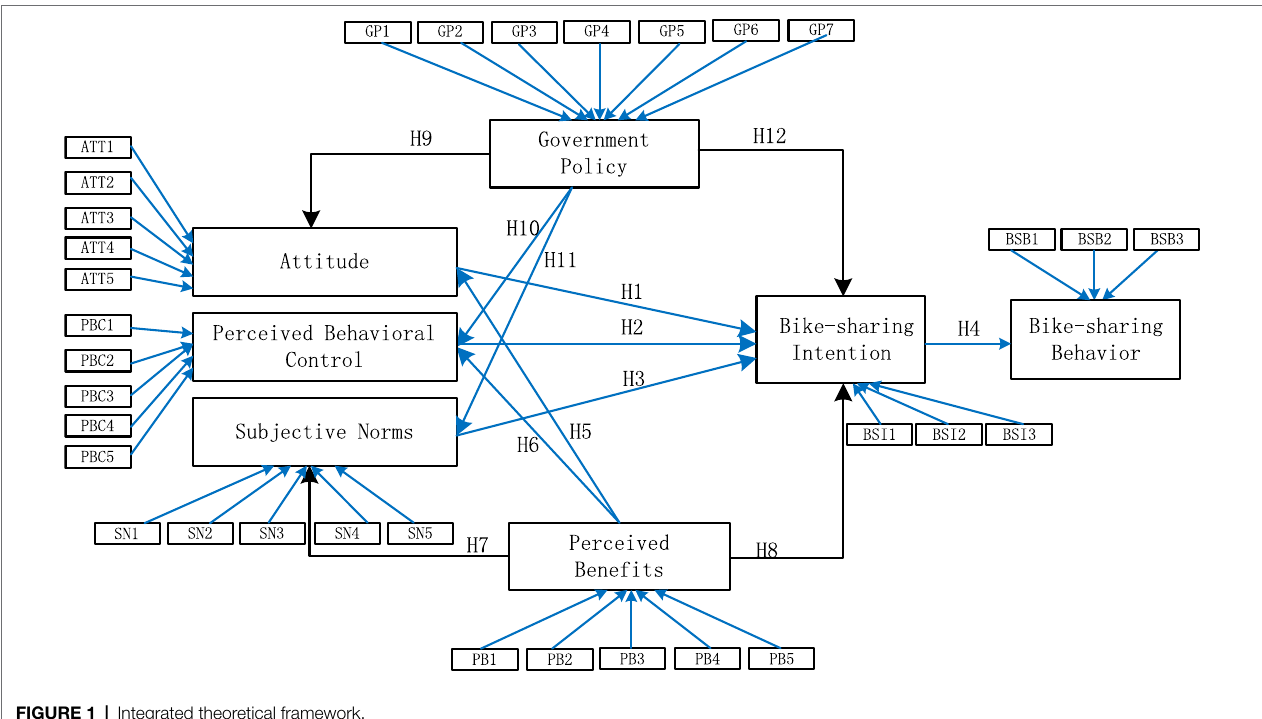
FIGURE 1 | Integrated theoretical framework.